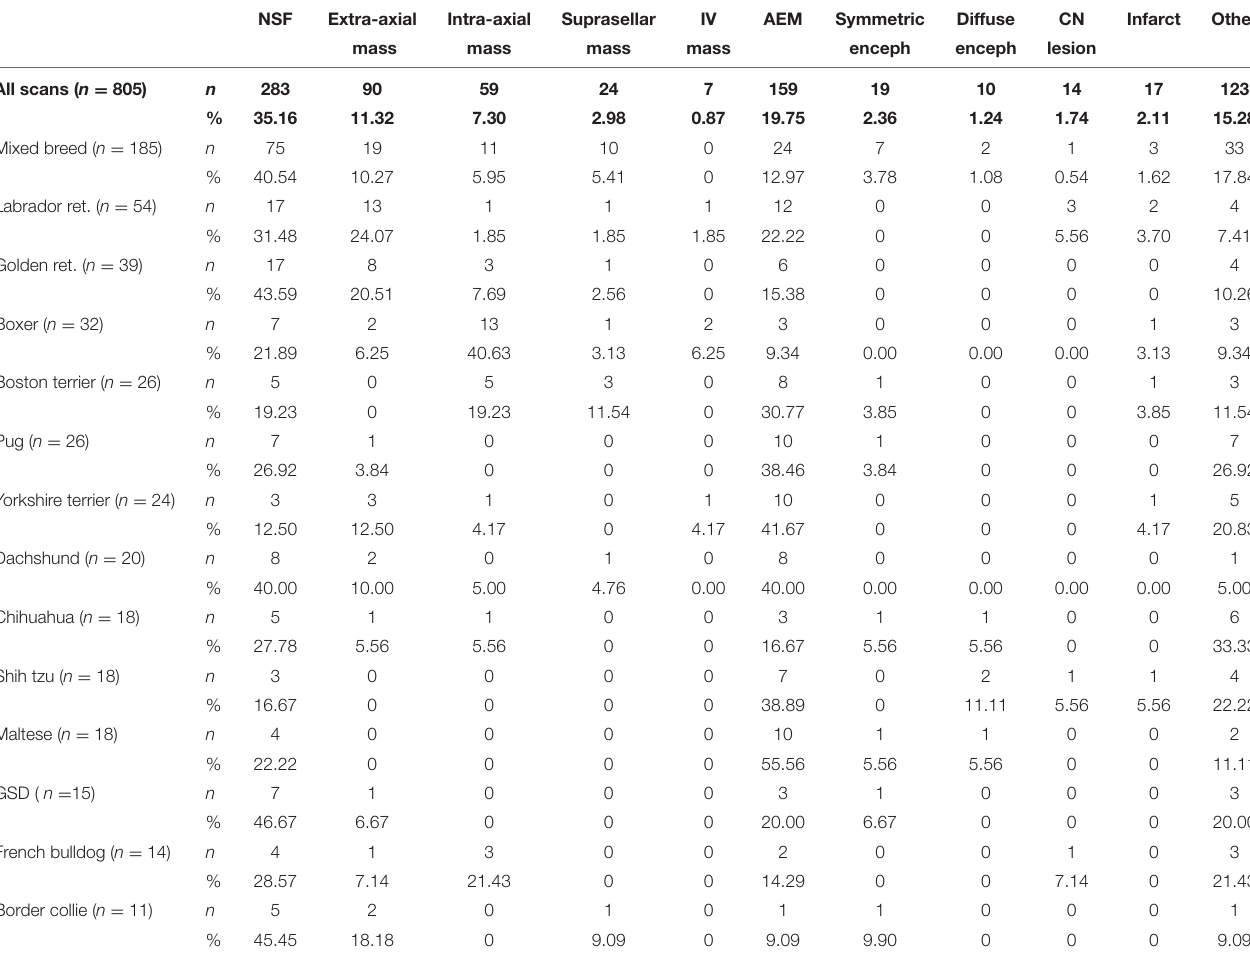
TABLE 2 | Distribution [number ( n ) and percentage (%)] of select canine brain imaging diagnoses by selected breed. NSF Extra-axial Intra-axial Suprasellar IV AEM Symmetric Diffuse CN Infarct Other mass mass mass mass enceph enceph